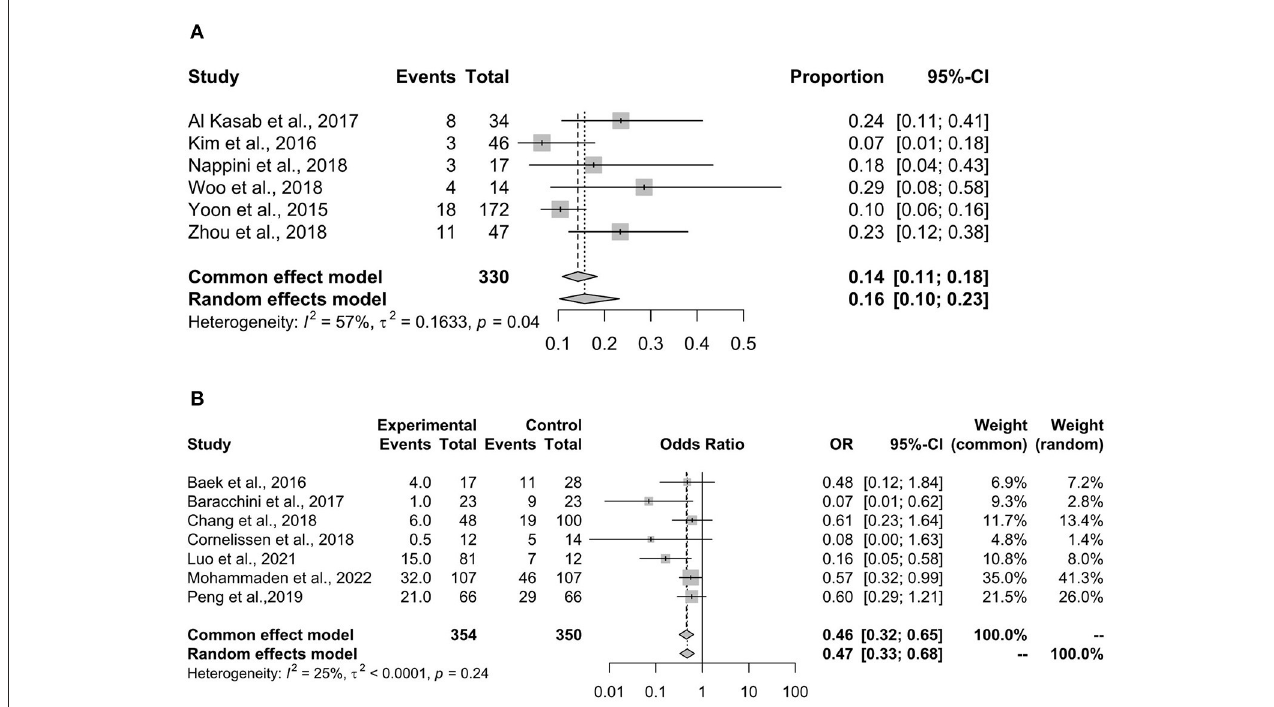
FIGURE4 90-day mortality. 90-day mortality is a negative outcome for patients receiving rescue stenting. (A) Summarizes the proportion of 90-day mortality. (B) Shows the comparison of stenting with non-stenting in the proportion of 90-day mortality, and a lower OR indicates a better result for the stenting arm. OR, odds